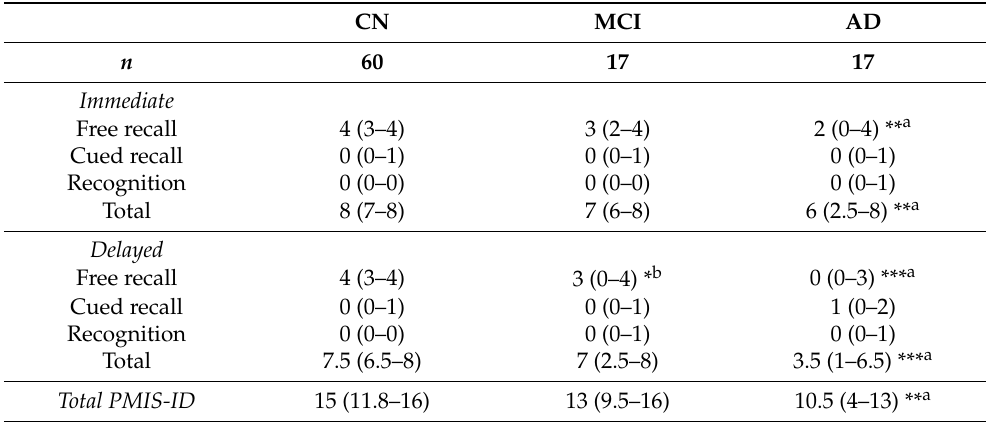
Table 4. PMIS-ID descriptive scores by